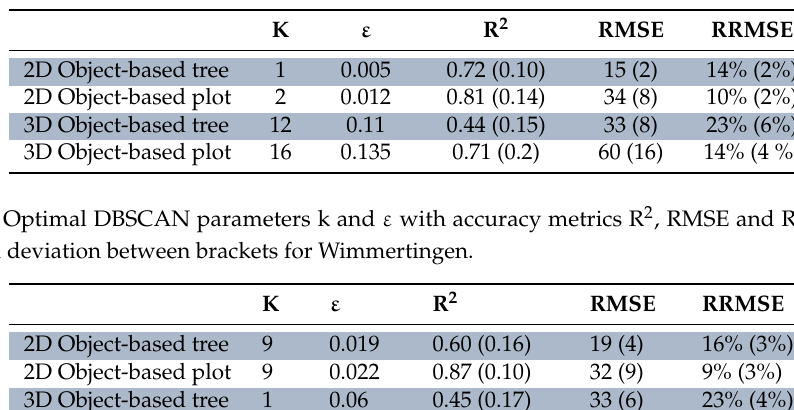
Table 1. Optimal DBSCAN parameters k and ε with accuracy metrics R 2 , RMSE and RRMSE with standard deviation between brackets for Rummen.